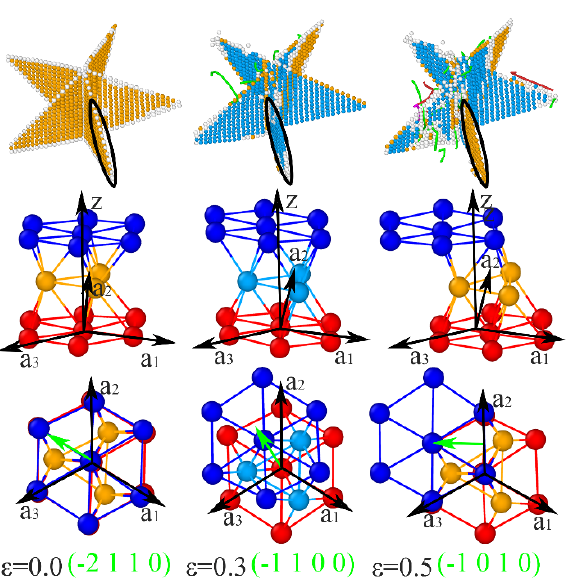
Figure 12. The basal slip system is divided into two steps in TBs in penta twins. The atoms around the TB atoms are colored dark blue and red.